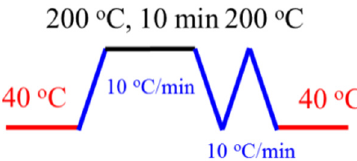
Figure 7. Differential scanning calorimetry (DSC) controlling curve.